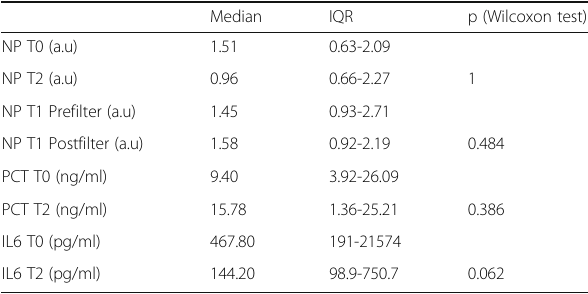
Table 1 (abstract 0305). Nucleoproteins (a.u: arbitrary units) and biomarker levels are shown Median IQR p (Wilcoxon test) NP T0